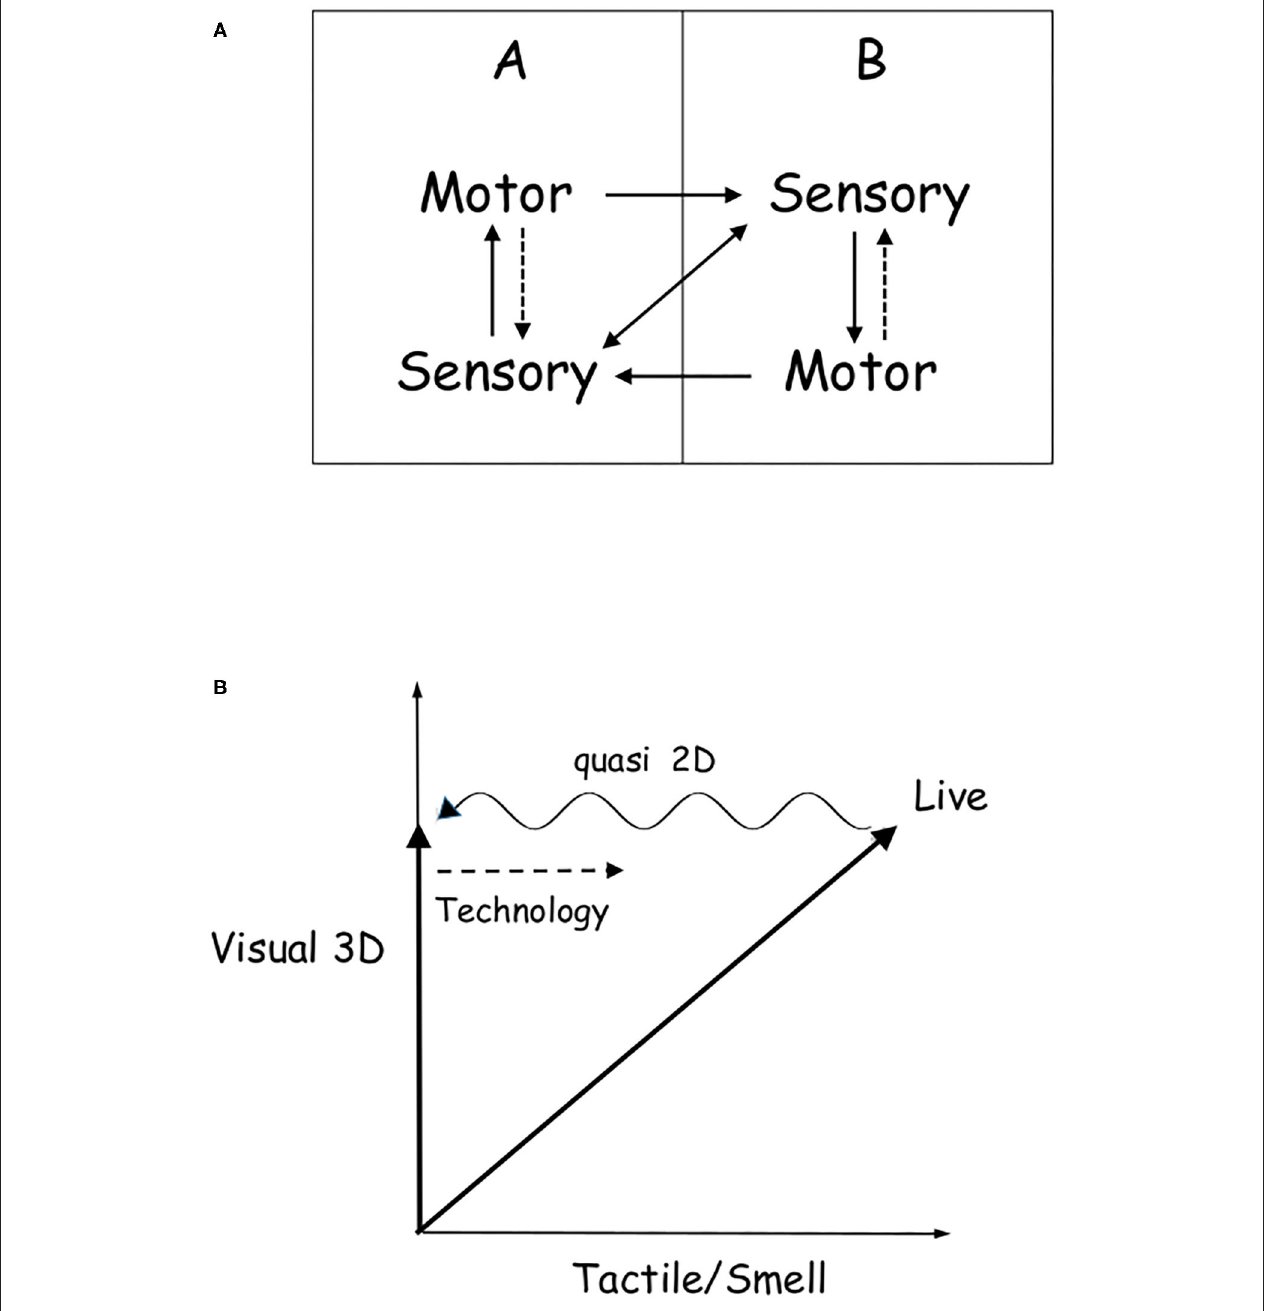
FIGURE 1 | (A) Simple scheme of a live interaction between individuals A and B. The two horizontal arrows indicate the mutual feedback between A and B, while the vertical ones denote the individual internal information exchanges between the sensory and motor systems. The vertical motor-to-sensory dashed arrows indicate the increased strength of sensory-to-motor (continuous arrows) when an individual interacts, thus, triggering the clockwise feedback loop, which represents the emergence of self-organizing behavior of A–B as a whole. The double diagonal arrow represents the direct interaction through the sensory system, e.g., eye contact or touch. (B) Qualitative sketch of the passage from live to online interactions. Live interactions involve both visual and tactile/smell senses, while online determines a reduced perception, represented in the figure as a shift toward the quasi 2D vision. The wave in the left arrow denotes that the projection on the vision axis is neither two- nor three-dimensional, but in between. The right dashed arrow represents technologies needed to (partially) fill the online–live interactivity gap. Being almost unchanged, auditory is not reported.